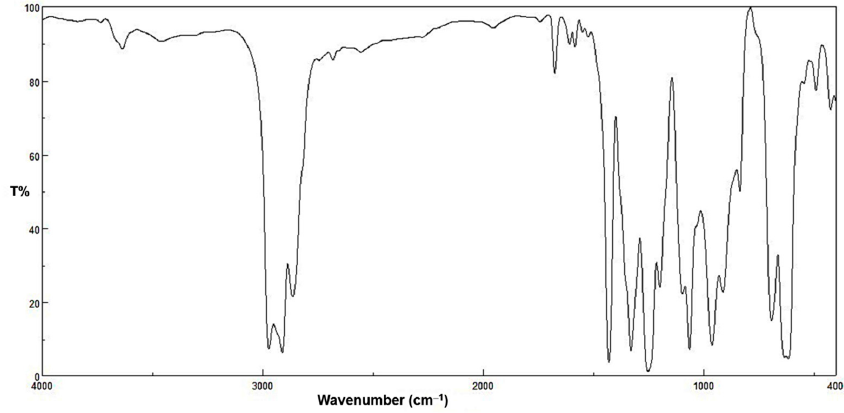
Figure 2. FTIR spectrum of poly(vinyl chloride) (PVC) film before irradiation.